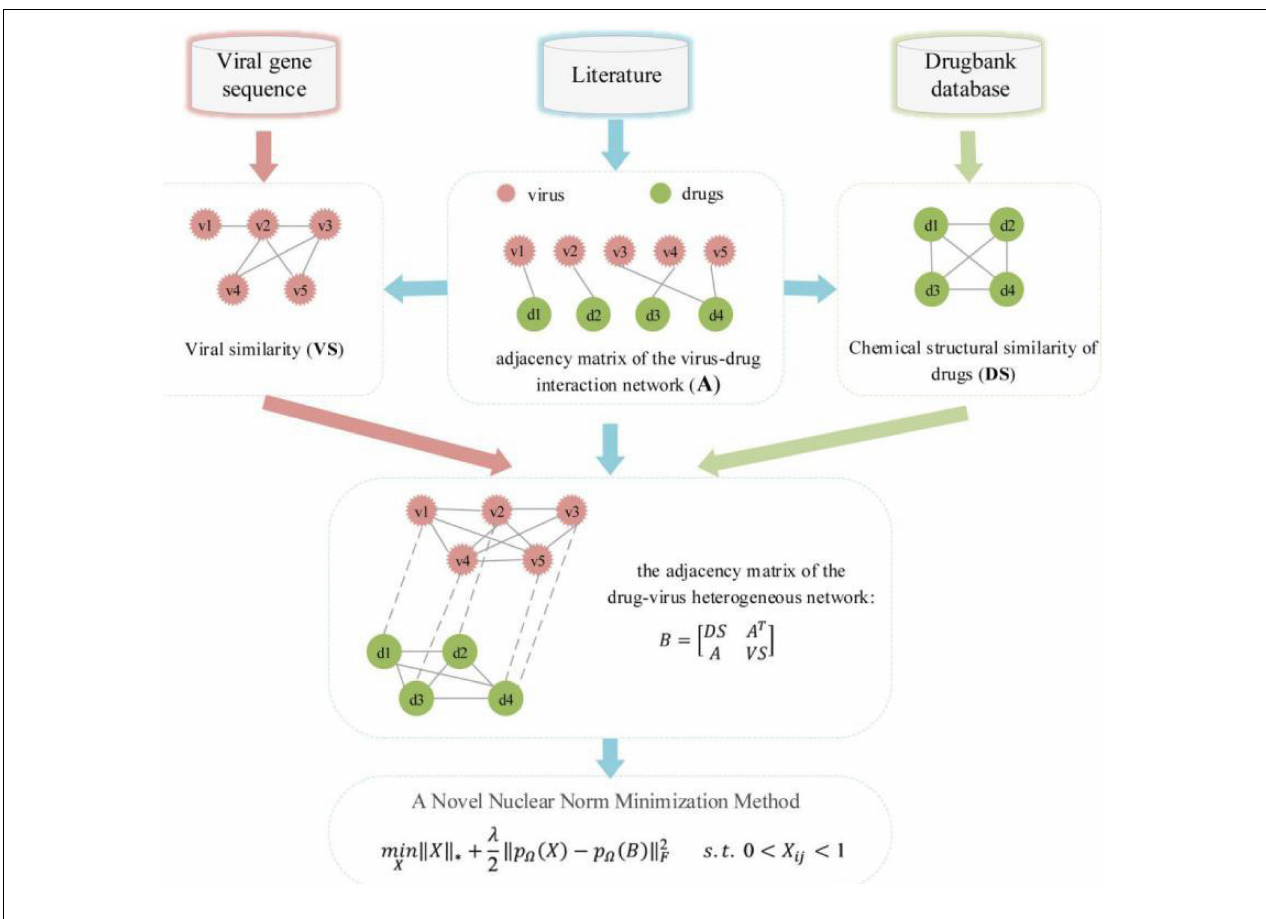
FIGURE 1 | The workflow of